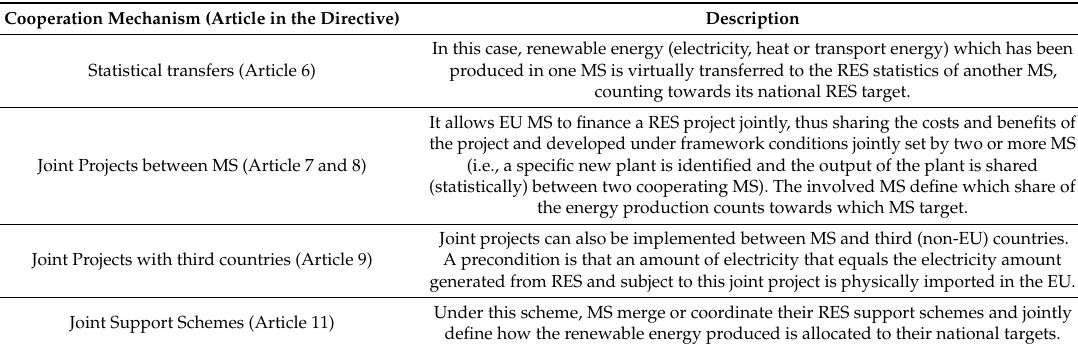
Table 1. The Cooperation Mechanisms of the RES